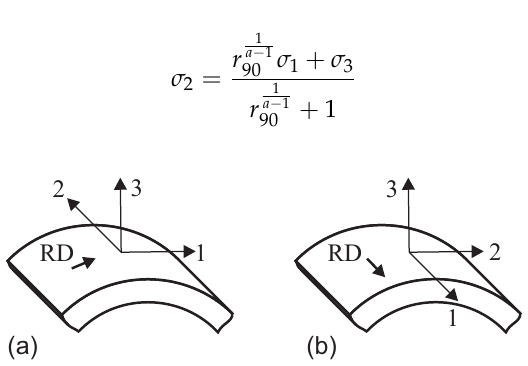
Figure A1. Stretch-bent metal sheet under plane-strain deformation: ( a ) d ε 2 = 0; ( b ) d ε 1 =